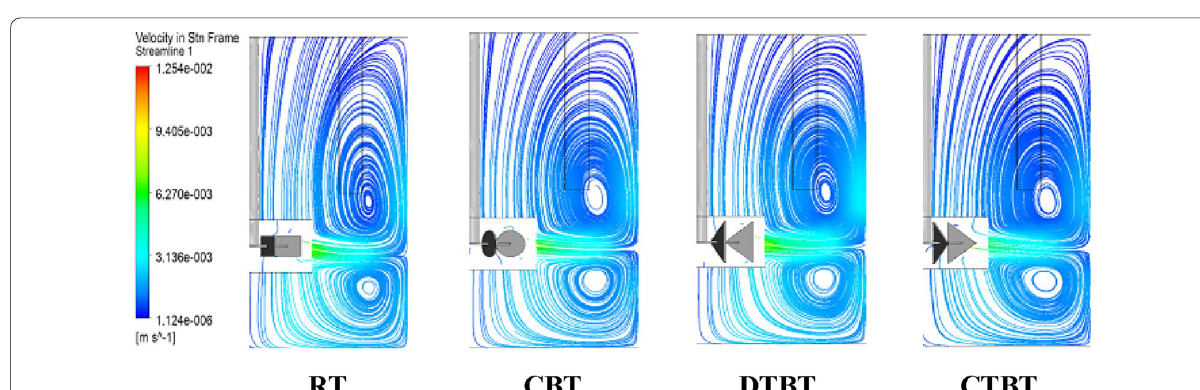
Figure 11 Stream lines for agitator’s types with L / H